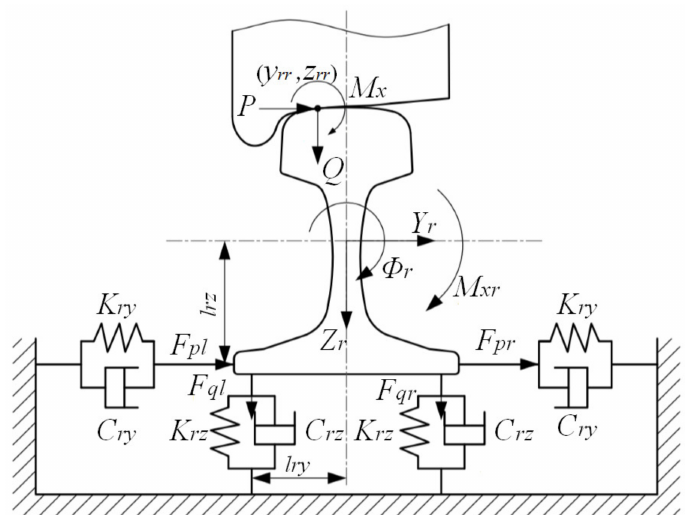
Figure 4. Equivalent model of track vibration